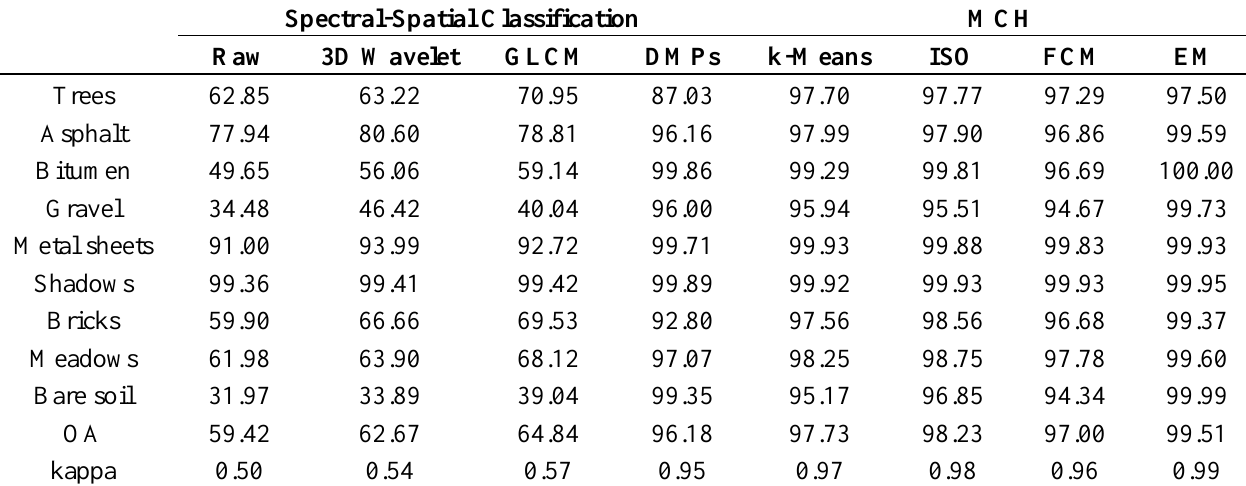
Table 7. Classification accuracies of the different features for the Pavia University